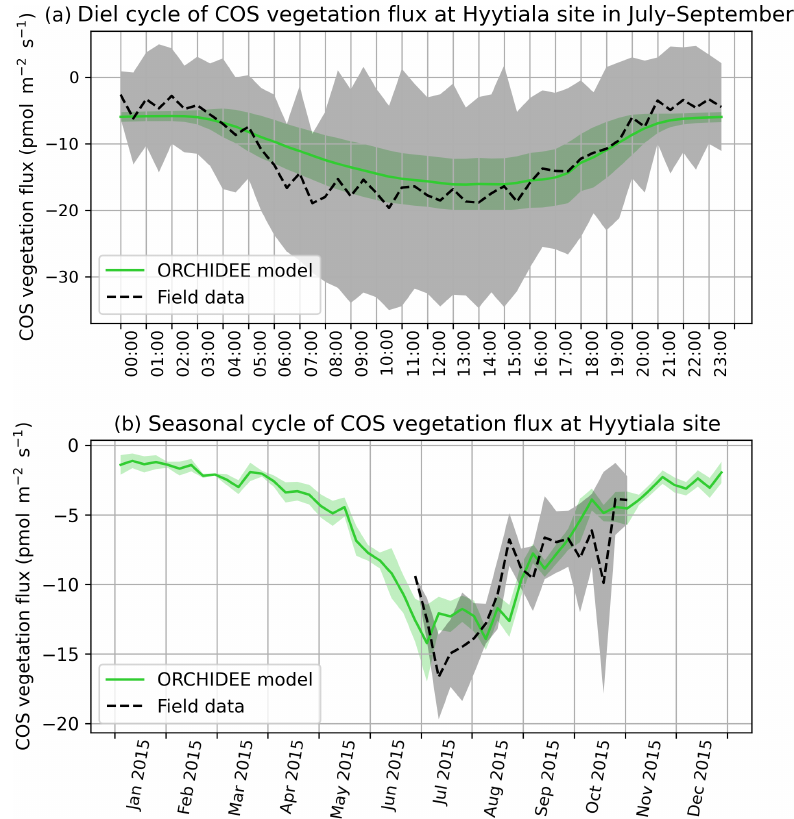
Figure B1. (a) Mean diel cycle of observed vegetation COS flux derived from ecosystem COS flux (Kohonen et al., 2020) and soil COS flux (Sun et al., 2018a), and modelled COS vegetation flux in July–September 2015, at Hyytälä, using an atmospheric convention where an uptake of COS by the ecosystem is negative. The shaded areas above and below each curve represent 1 standard deviation of the considered half-hourly values over the July–September period. (b) Mean seasonal cycle of simulated and observed weekly average vegetation COS flux in 2015, at Hyytälä. The shaded areas above and below each curve represent 1 standard deviation of the daily means within the considered